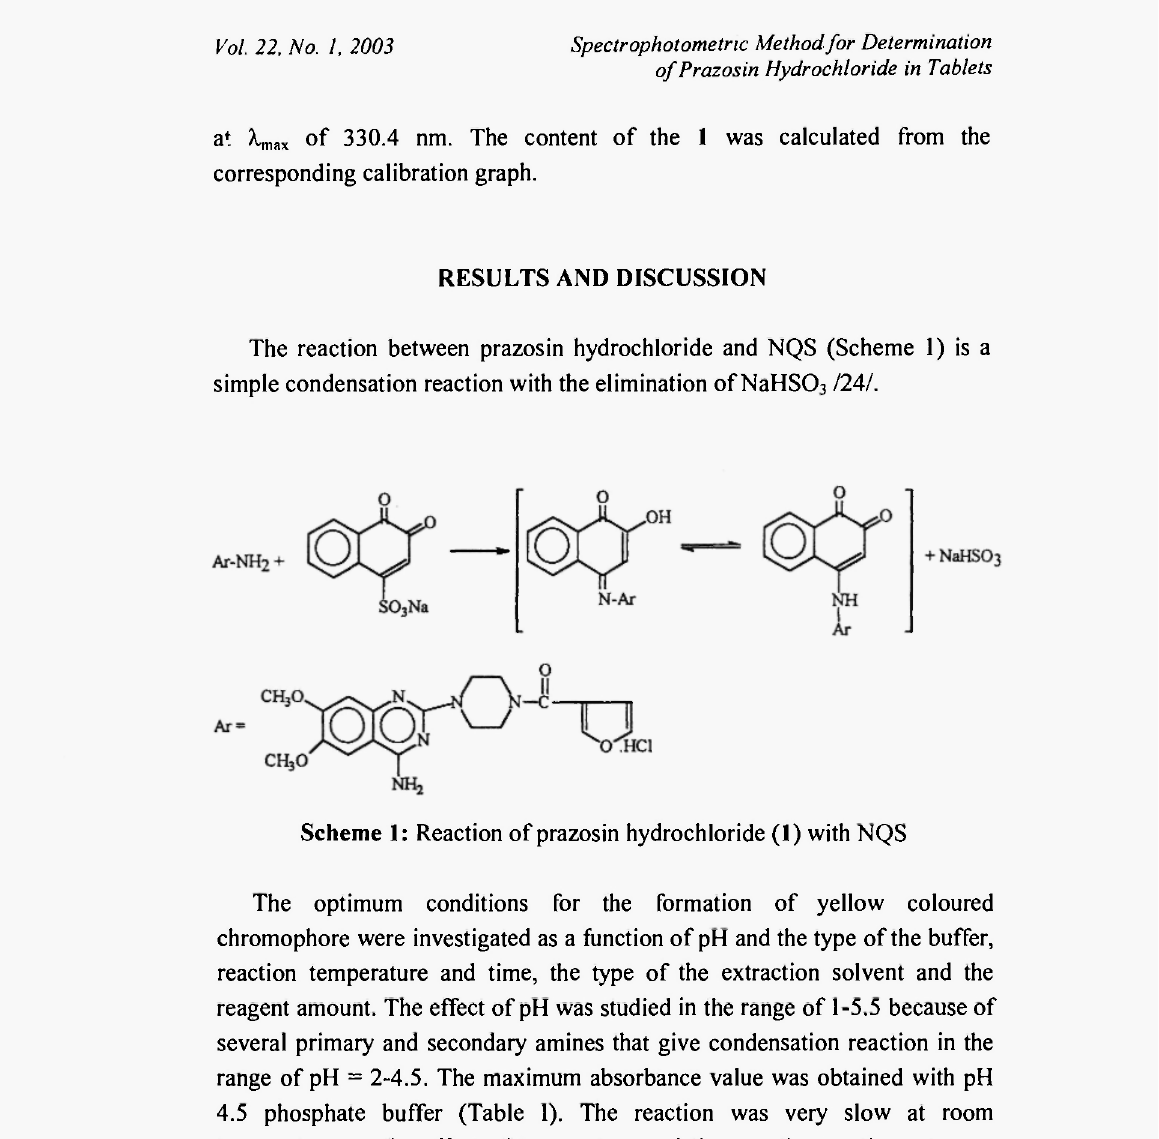
Effect of the pH on the